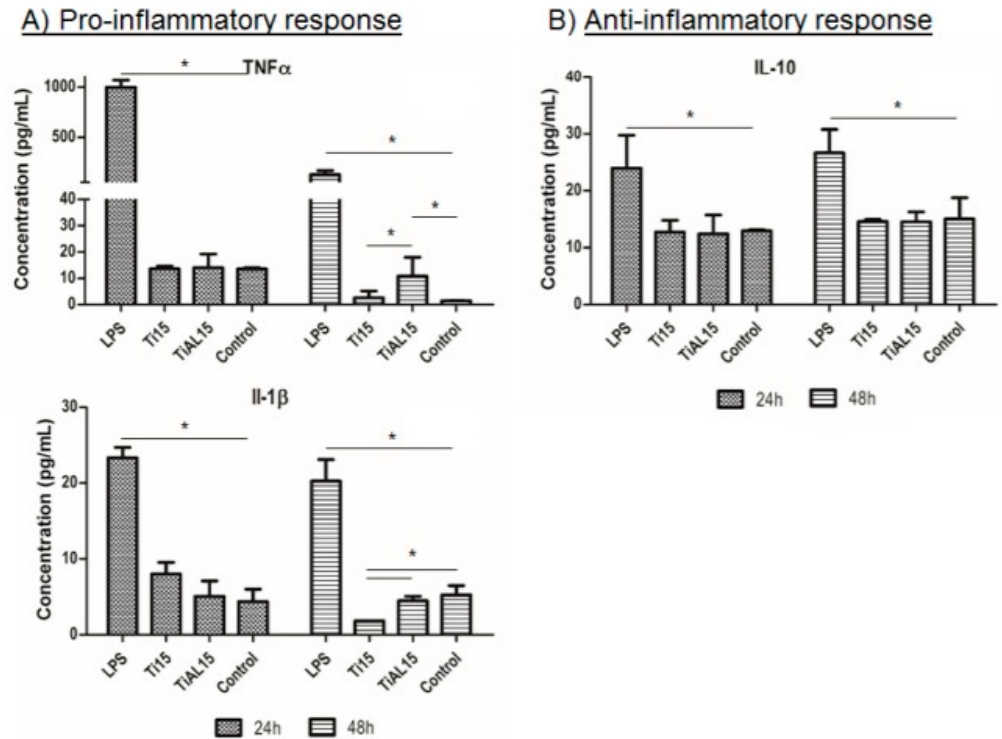
Figure 10. Protein analysis of the inflammatory response in THP–1 cells for pro–inflammatory ( A ) and anti–inflammatory ( B ) markers. Cells cultured with extracts of microparticles of Titanium (Ti15) and the alloy of titanium, aluminium and vanadium Ti6Al4V (TiAL15). * p < 0.05.